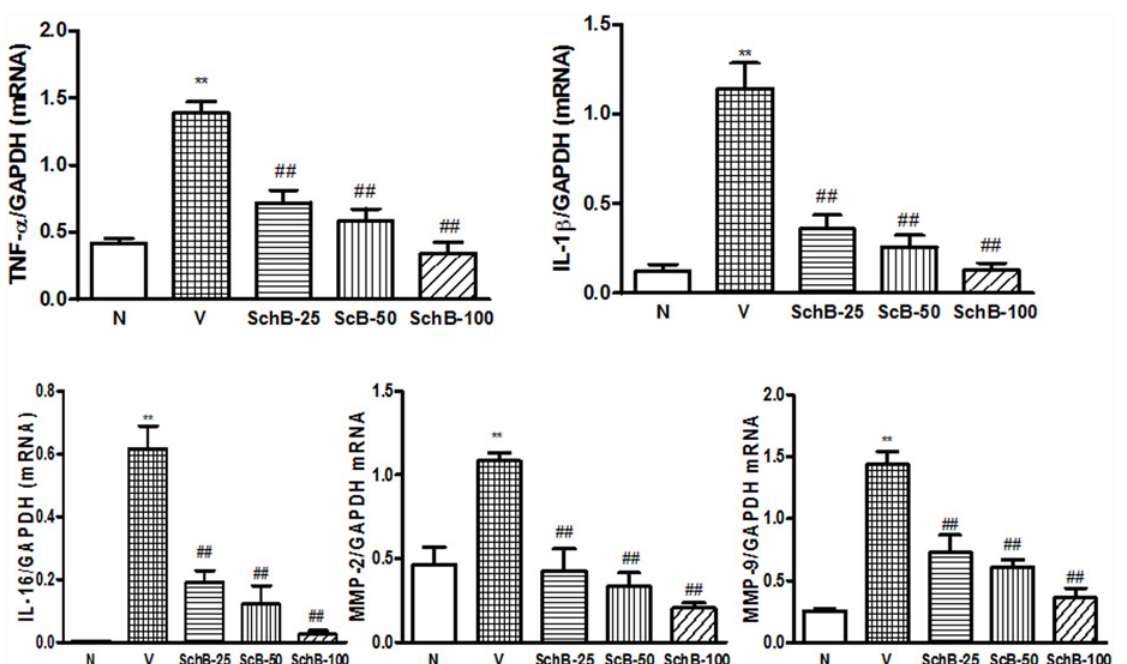
Fig 9. Sch B inhibits the Dox-induced messenger RNA expression of LV cytokines and MMP levels 5 days after Dox injection. (A – E) mRNA expression of TNF- α (A), IL-1 β (B), IL-16 (C), MMP-2 (D) and MMP-9 (E) in group N, group V and Sch B treated mice. The expression level of each sample was expressed relative to the expression level of GAPDH gene. Each bar represents means ± S.E. (n = 3 – 5). ** P < 0.01 vs. group N mice; # P < 0.05 and ## P < 0.01 vs. group V